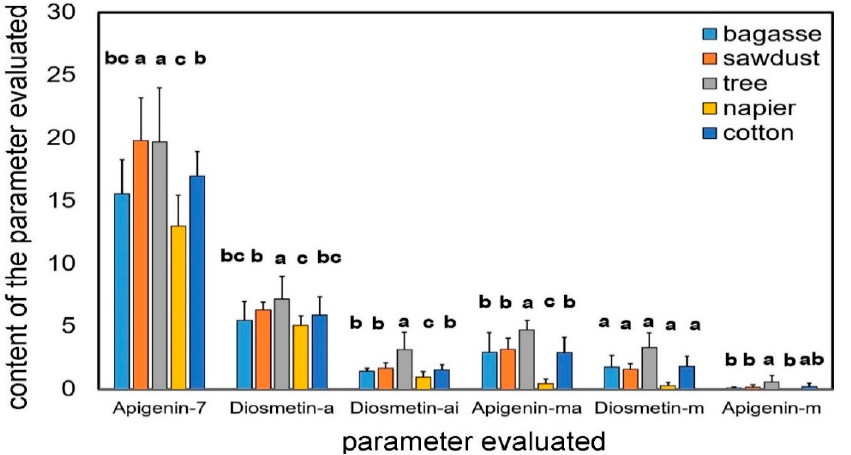
Figure 3. Flavonoid composition (apigenin-7-apiosylglucoside, diosmetin-apiosylglucoside, diosmetin-apiosylglucoside isomer, apigenin-malonyl-apiosylglucoside, diosmetin-malonyl- apiosylglucoside, and apigenin-malonylglucoside in mg g − 1 ; y -axis) in shoots of parsley plants grown in medium composed of bagasse–chicken compost + biochar, sawdust–chicken compost + biochar, tree–chicken compost + biochar, napier–chicken compost + biochar, and cotton–chicken compost + biochar. Biochar was added to the composts at five inclusion rates (0, 15, 30, 45, and 60%, weight basis) and the average values used in statistical analyses. Error bars represent standard deviations. For each parameter, bar values followed by the same letter are not statistically different ( p < 0.05; ANOVA Duncan post-hoc